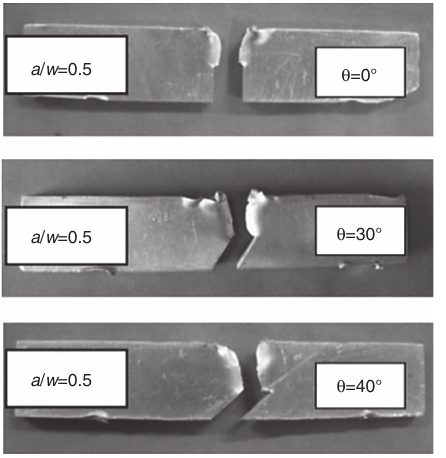
Figure 7 Crack trajectory in different crack angles at crack length ratio of a / w = 0.5.